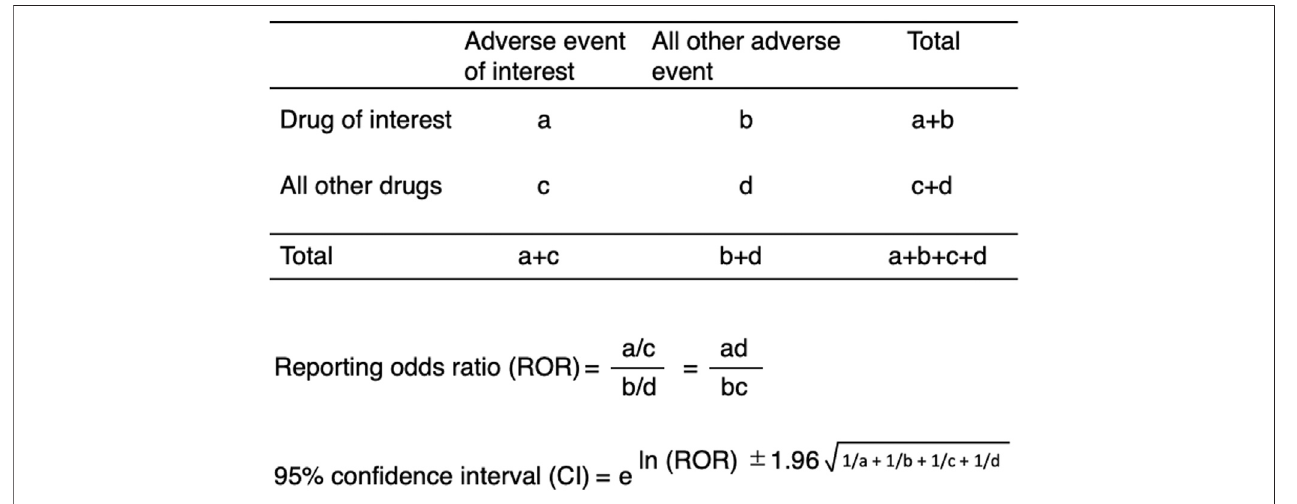
FIGURE 2 | Two by two contingency table for